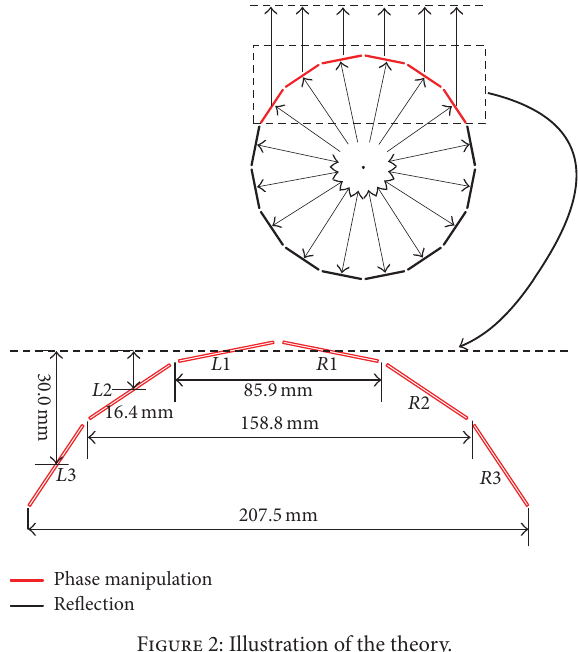
Figure 2: Illustration of the theory.